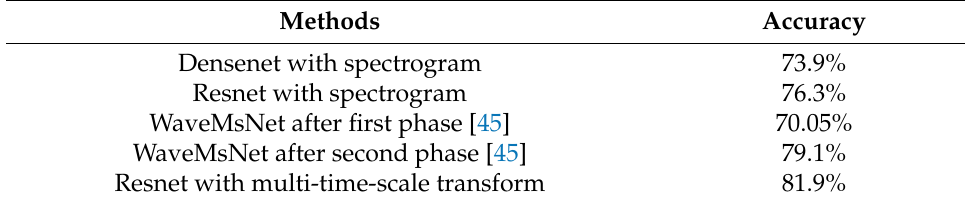
Table 2, the application of our multi-time-scale transform to resnet resulted in about 2.8% higher accuracy than that of the baseline network, WaveMsNet. Table 2. Ablation study of the multi-time-scale transform.